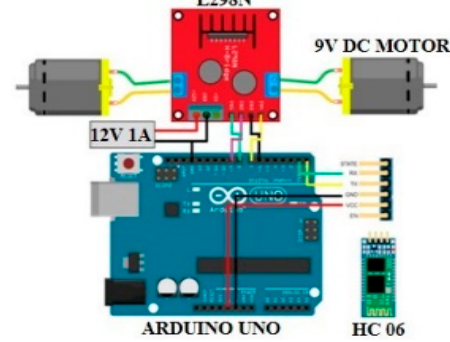
Figure 5. Overview of the data communication module system.